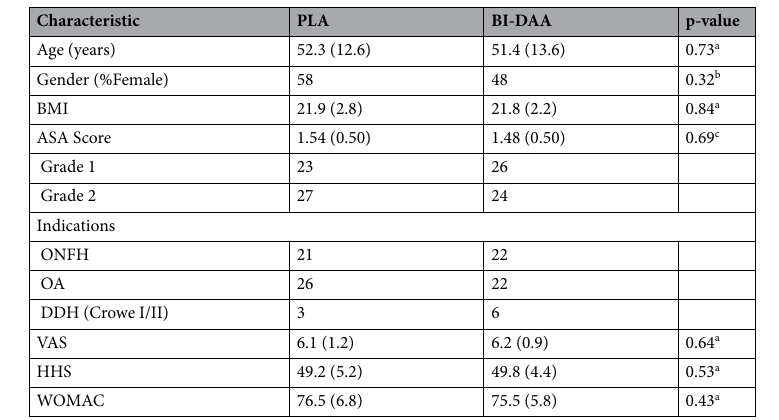
Table 1. Preoperative characteristics of patients. Values are n (%) or mean (SD). P value < 0.05 considered statistically significant. BI-DAA bikini-incision via direct anterior approach, PLA posterolateral approach, BMI body mass index, ASA American society of anesthesiologists, ONFH osteonecrosis of femoral head, OA osteoarthritis, DDH developmental dysplasia of the hip. VAS visual analogue scale, HHS harris hip score, WOMAC the western ontario and mcmaster universities osteoarthritis index, SD standard deviation. a Student’s t test; b Chi-squared test; c Mann–Whitney U-test.